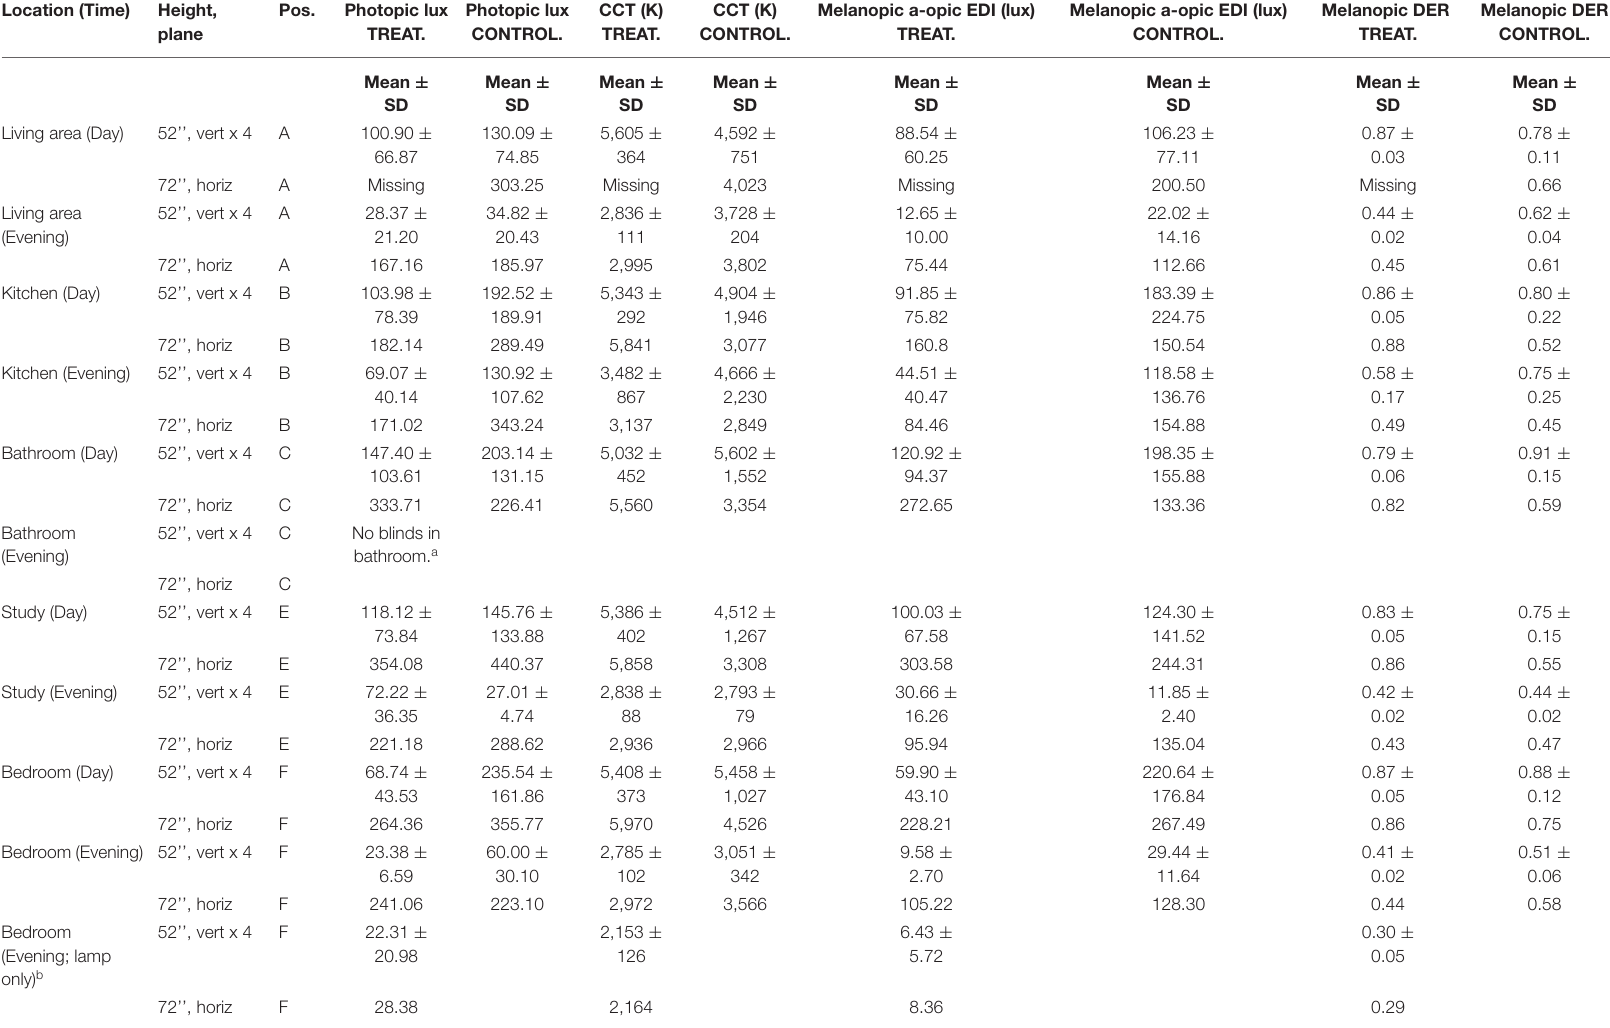
TABLE 1 | Case 1 Treatment and Control condition lighting measurements. Location (Time) Height, Pos. Photopic lux Photopic lux plane TREAT.